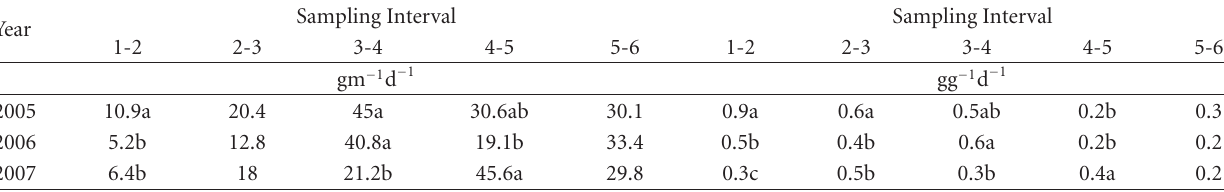
Table 4: Crop Growth Rates ( gm − 1 d − 1 ) and Relative Growth Rates ( gg − 1 d − 1 ) of Six Herbicide Resistant Corn Hybrids From Growth Stage V3 Until Growth Stage R1, Grown at Stoneville, MS. †